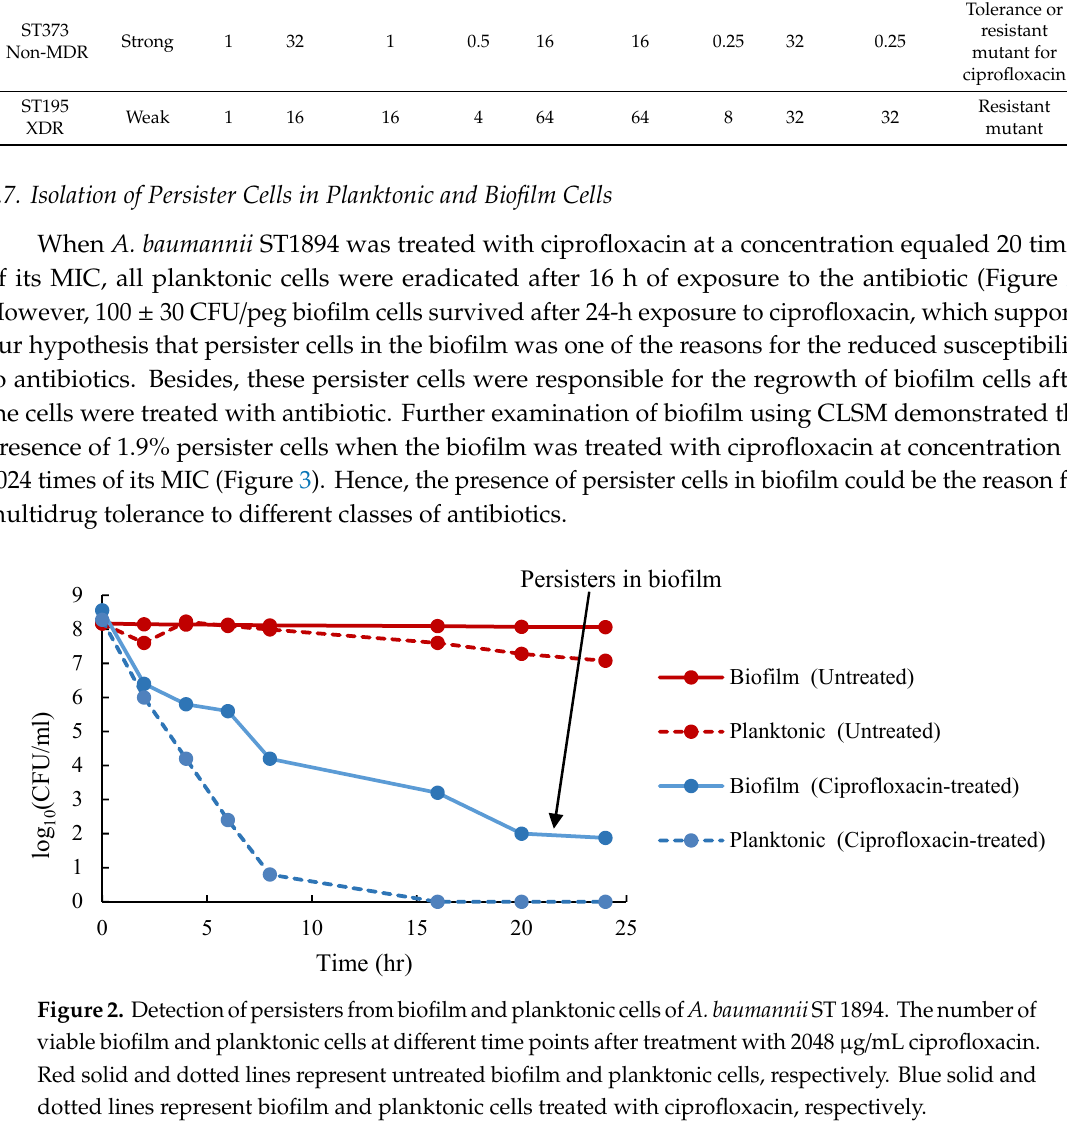
Figure 3. CLSM image of A. baumannii ST1894 biofilm treated with ciprofloxacin at 1024 × MIC. Viable bacterial cells in the biofilm was detected by a Live/Dead Biofilm Viability Kit. Persister cells appear green in color, dead cells appear red in color. 5. Discussion